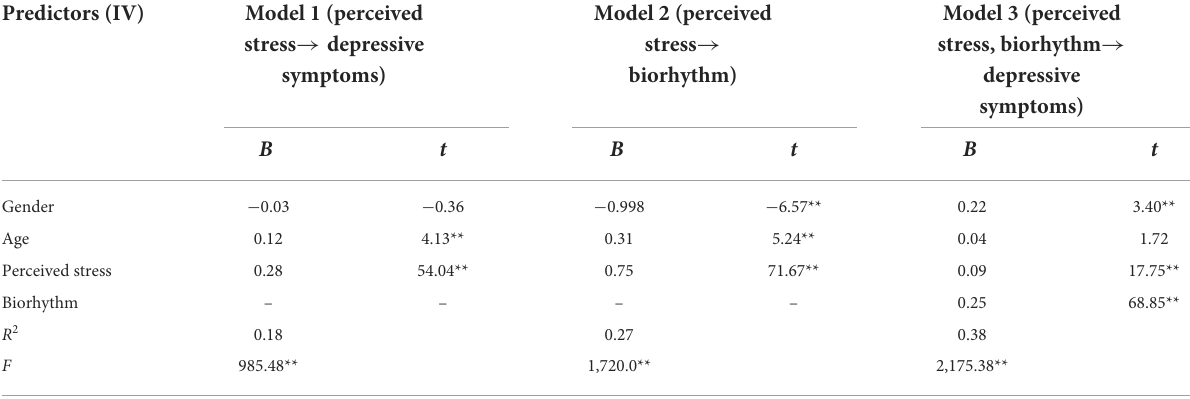
TABLE 2 Mediating effect of biorhythm between perceived stress and depressive